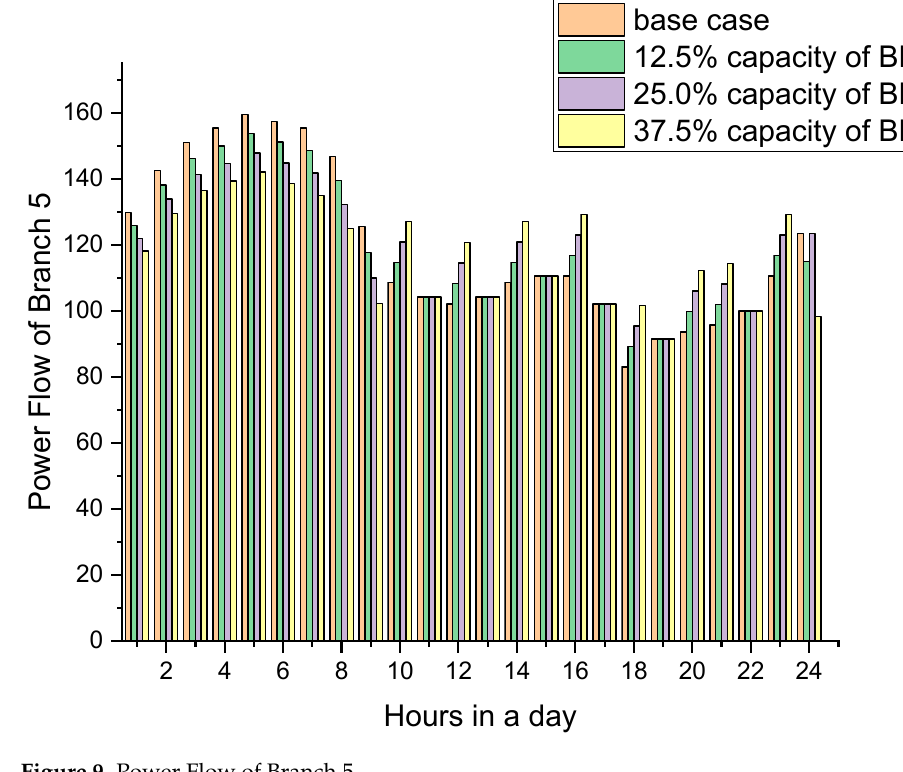
Figure 9. Power Flow of Branch 5. Table 6. Cost Savings of LSEs compared to Base Case.